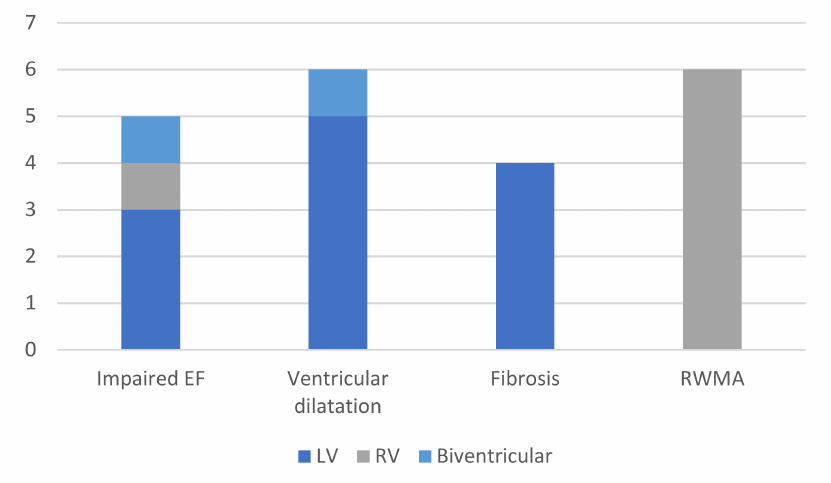
Figure 2. Summary of the CMR findings. LV = left ventricle, RV = right ventricle. RWMA = regional wall motion